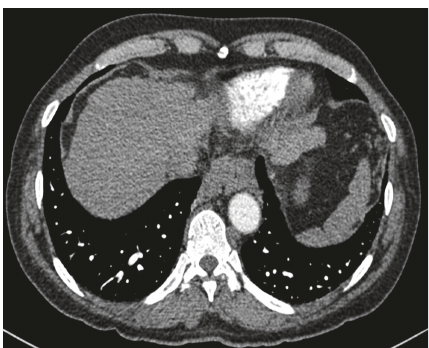
Figure 3: Chest CT scan showing the prominent pulmonary vasculatures and irregular borders of the liver.